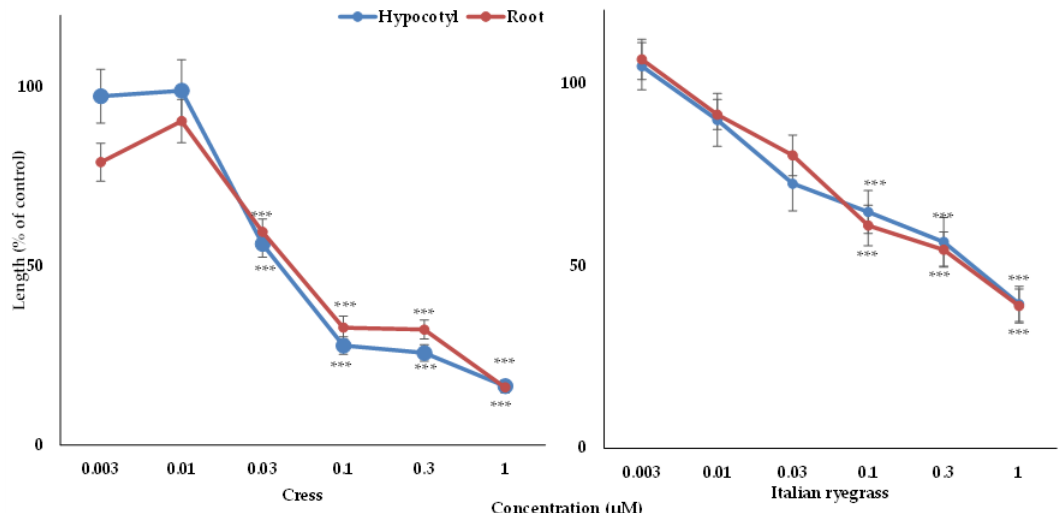
Figure 5. Effect of vanillic acid on the seedling’s growth of cress and Italian ryegrass: mean ± SE from the two separate experiments with three replications (10 seedlings for each replication) for every experiment that is displayed. Asterisks signify important variations between treatments and control: *** p < 0.001 (ANOVA one-way and LSD test by post hoc).